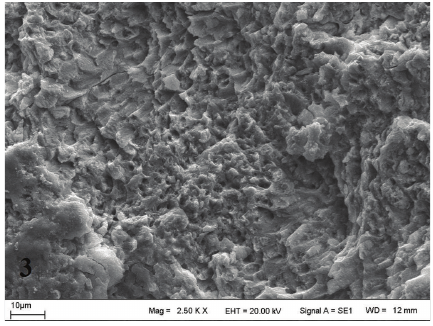
Figure 3: SEM micrograph of dentin surface treated with 4 W laser in Group C (original magnification × 2.50